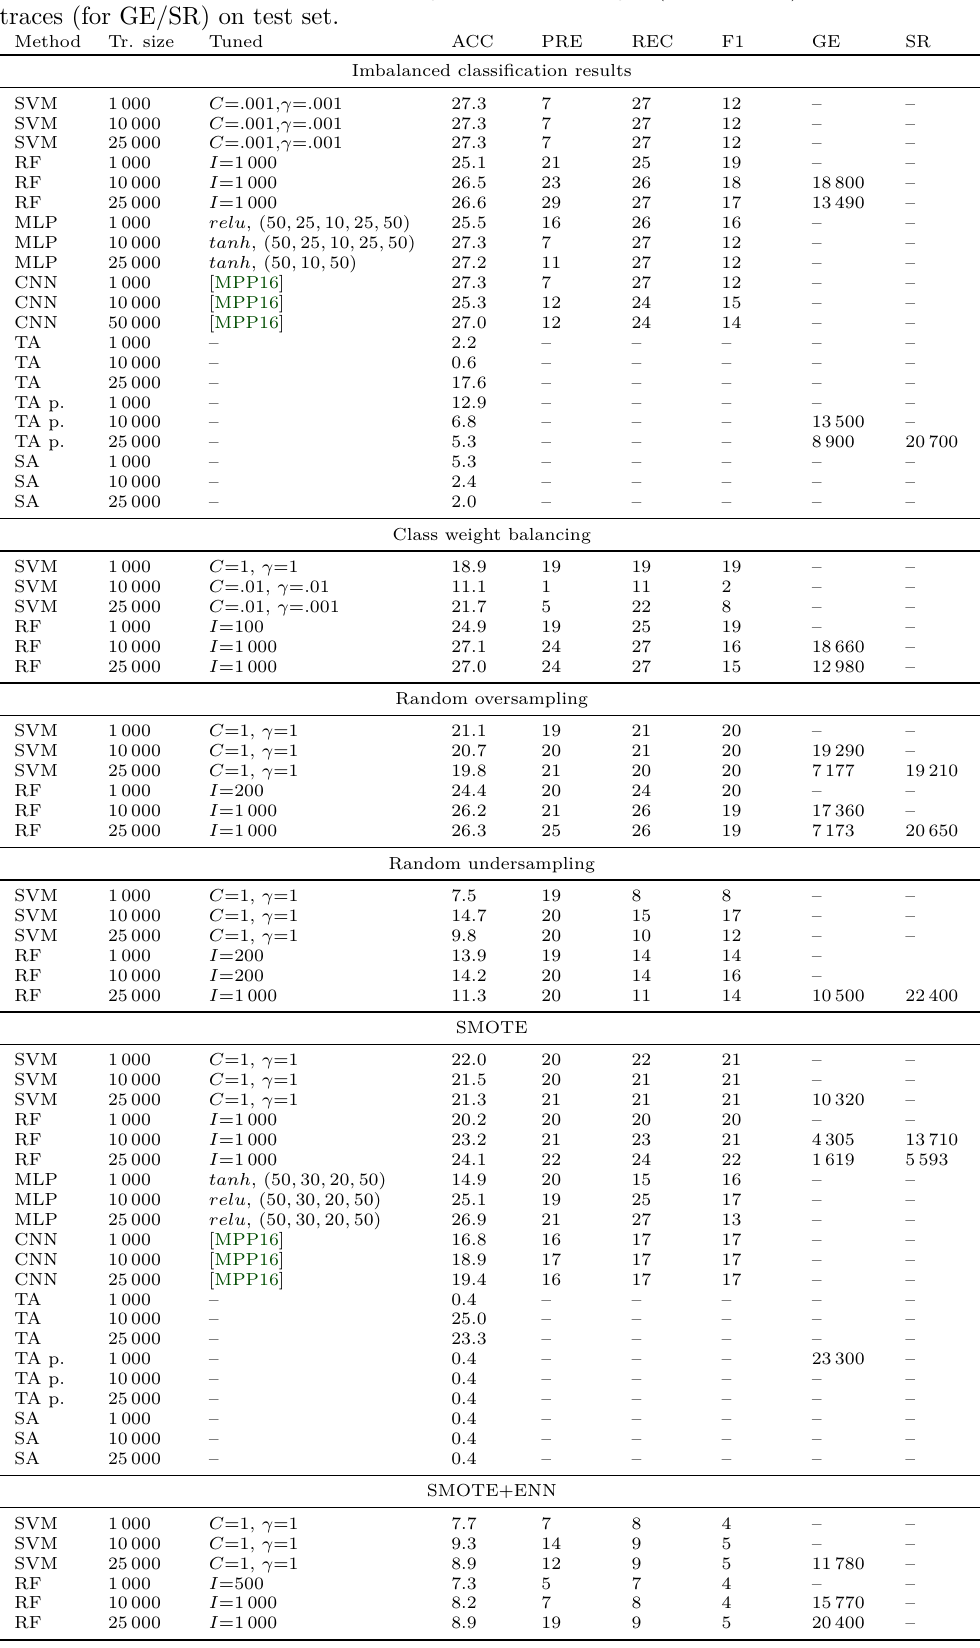
Table 6: AES_RD dataset. Values are given as percentages (ML metrics) and number of traces (for GE/SR) on test